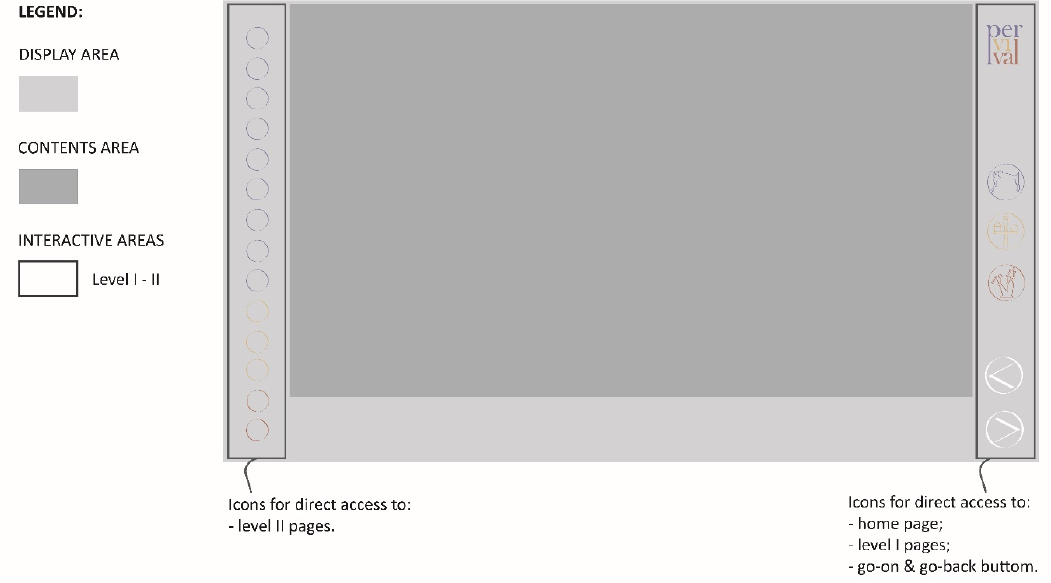
Figure 7. Digital app interface showing an example of the navigation Level II page with the main Figure 6. The layout of the digital application, referred to as Level I, II and III. Figure 7. The layout of the digital application, referred to as Level I, II and III.